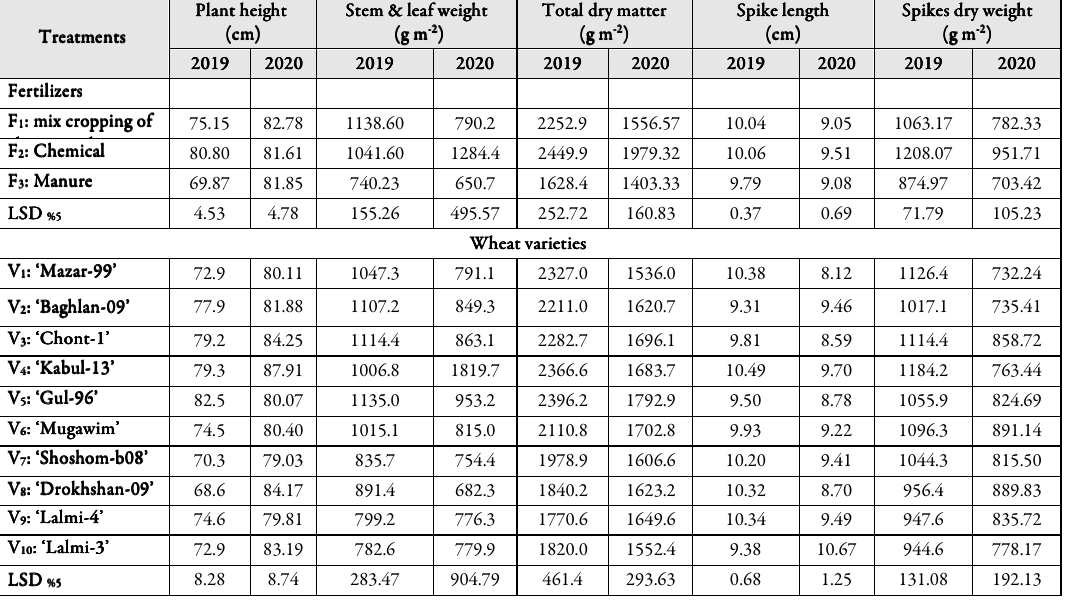
Table 3. Means comparison for the effect of fertilization and different wheat varieties on vegetative